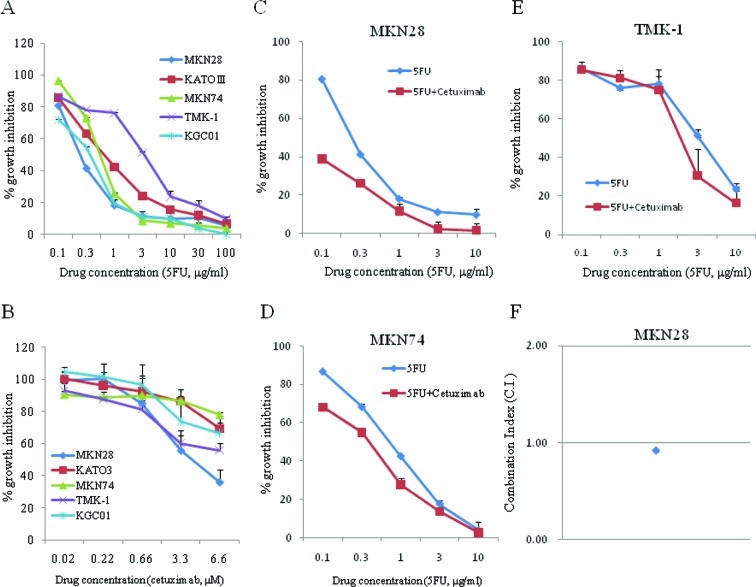
Anti-proliferative effects of 5FU monotherapy, cetuximab monotherapy and combination 5FU/cetuximab in vitro. (A, B) GC cells were maintained in supplemented medium for 12 h and then incubated with 5FU (0.1–100 μg/ml) or cetuximab (0.02–6.6 μM) for 72 h. (C–E) EGFR-amplified MKN28 cells or non-EGFR-amplified MKN74 and TNK-1 cells were incubated for 72 h with 5FU (0–10 μg/ml) and cetuximab at a fixed cetuximab concentration of 3.97 μM, after which cell viability was measured. (F) The interaction between the two agents was evaluated on the basis of the CI. CI values of <1, 1 and >1 indicate synergistic, additive and antagonistic effects, respectively. Data are means of triplicates from a representative experiment.